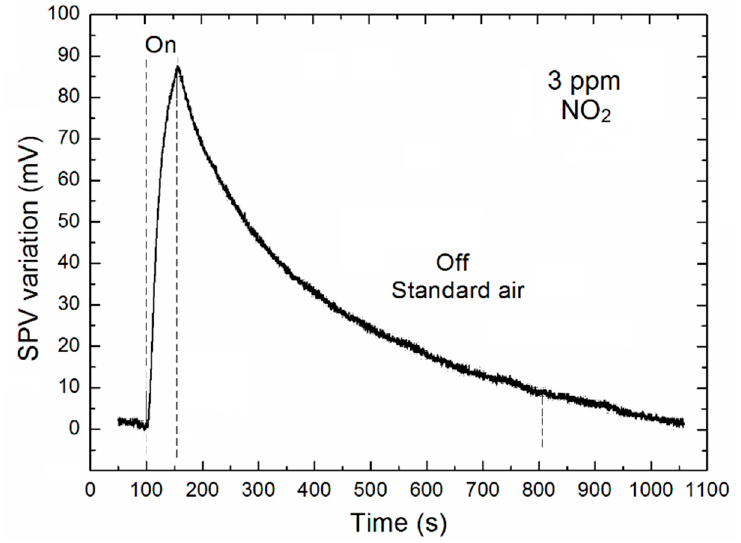
Figure 5. The variation of SPV signal as a function of time for the 3 ppm NO 2 concentration. Table 1. Response time and respective recovery time of SPV signal of our SPV gas sensor device for the main range of NO 2 concentration used in our experiments.